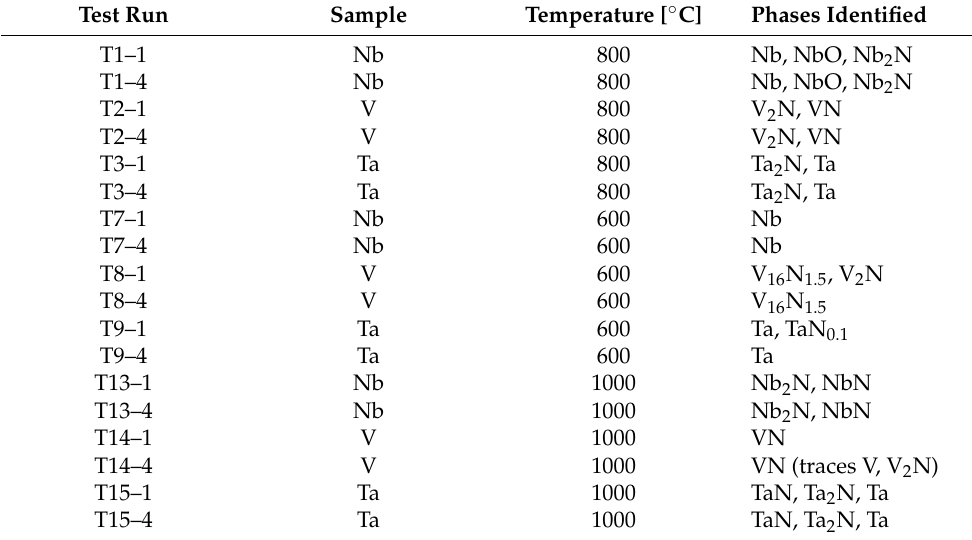
Table 2. Test conditions and phases identified by